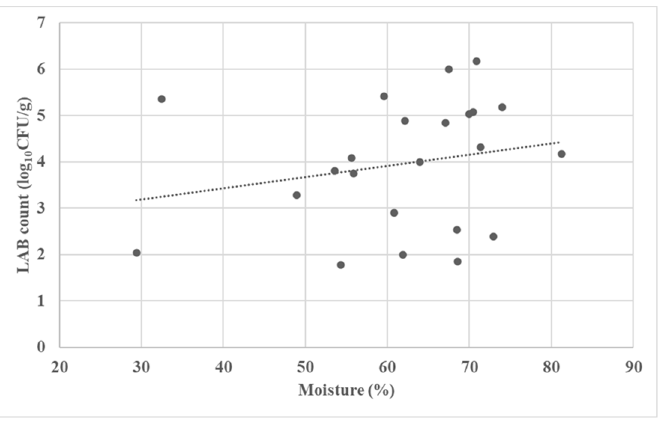
Figure 2. Correlation of water content and LAB counts in fermented forages.